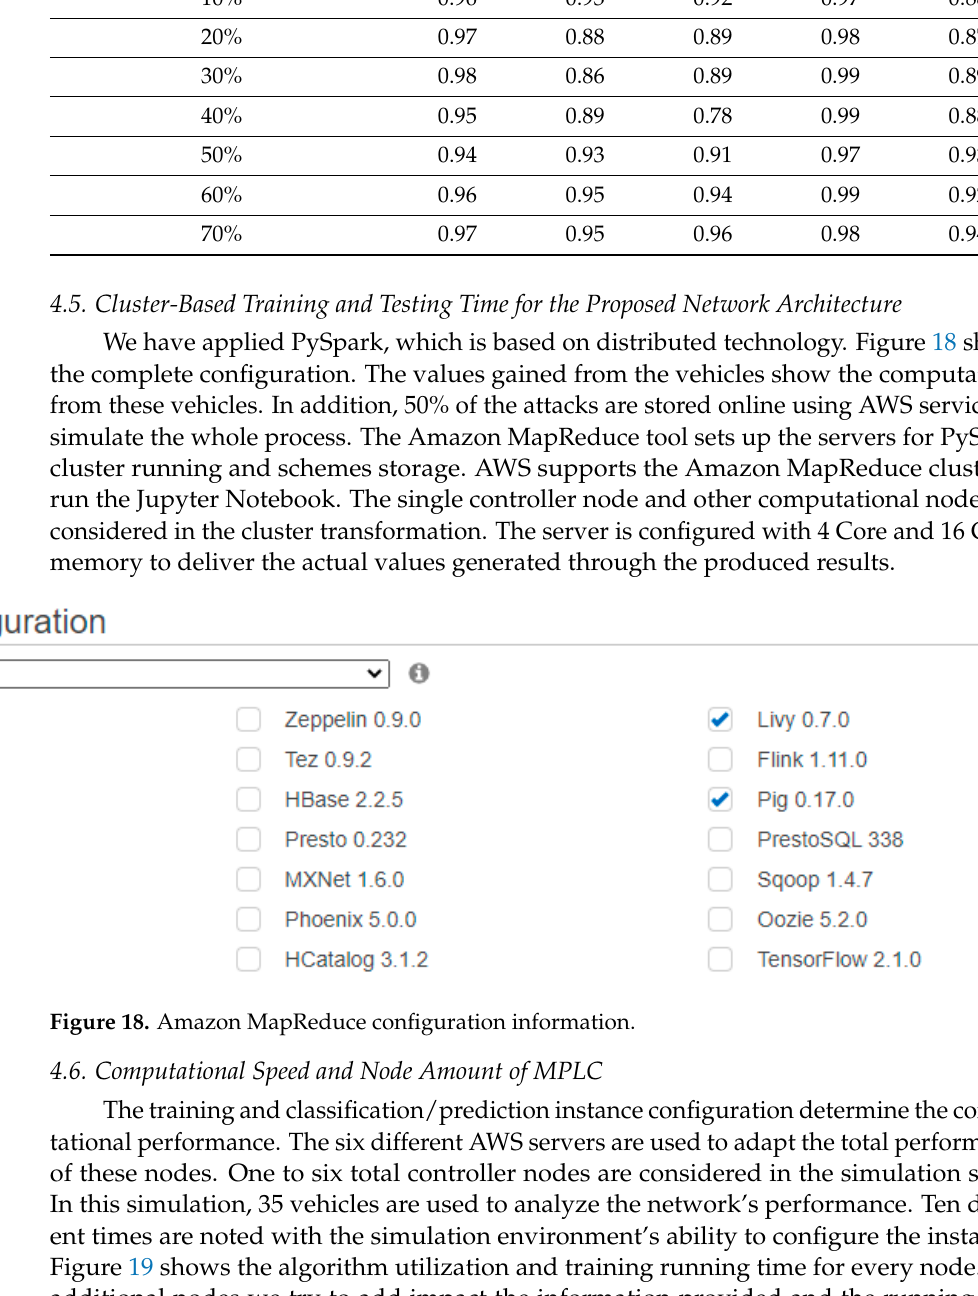
Figure 17. F1 Score values for multiple models for network attacks.